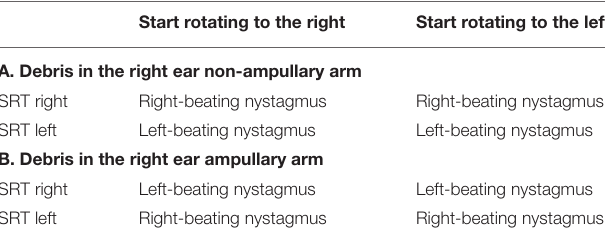
TABLE 1 | It presents understanding of the effect of Supine Roll test on horizontal canalithiasis affecting (A) the non-ampullary and (B) ampullary arms (6, 16, 20–23). Start rotating to the